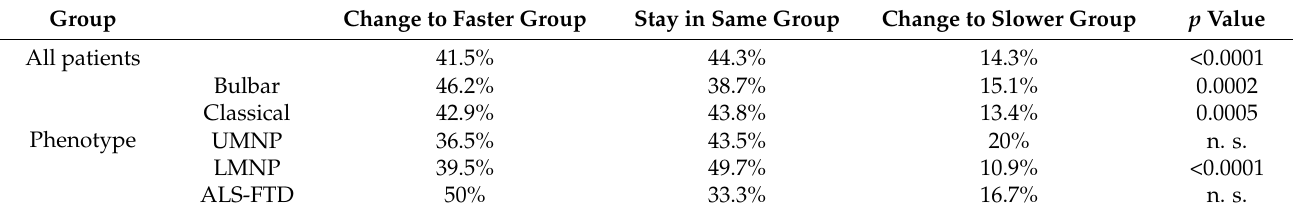
Table 3. McNemar–Bowker test for slope group